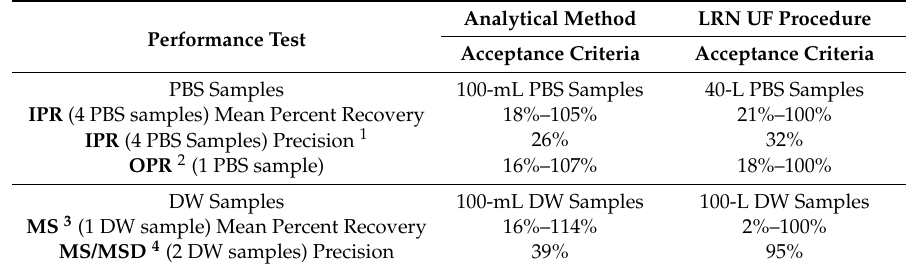
Table 4. Calculated IPR, OPR, MS and MS/MSD criteria for analytical method (100-mL samples) and